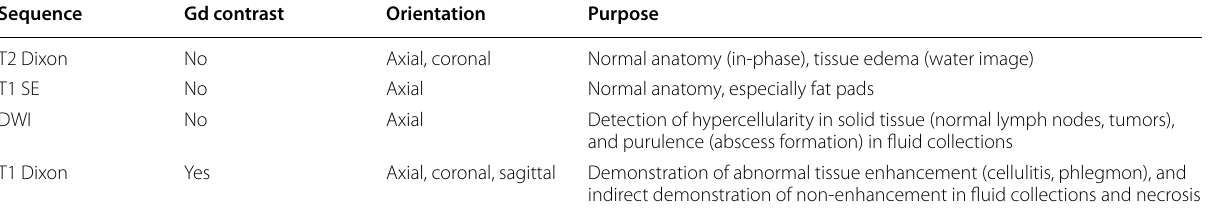
Table 1 MRI protocol for acute neck infections Sequence